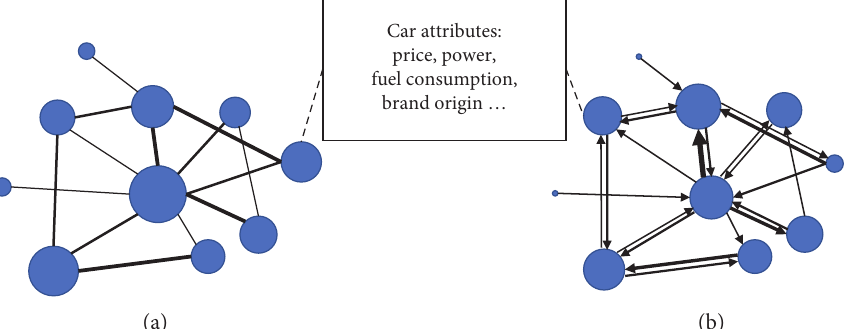
Car attributes: price, power,